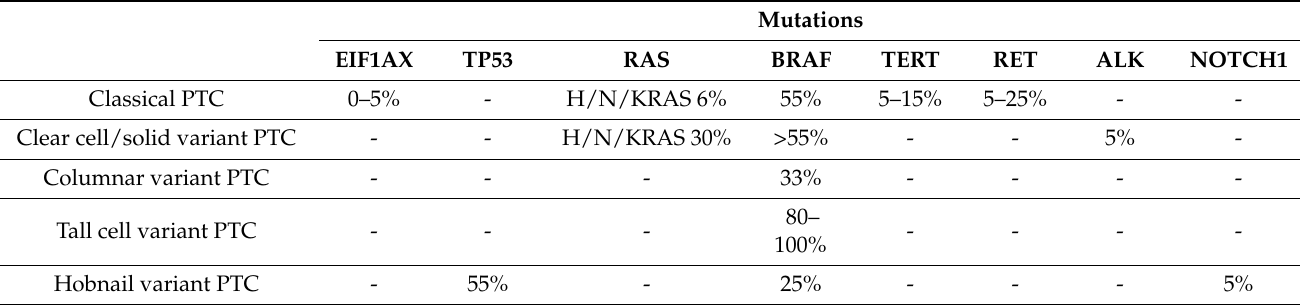
Table 3. Histological and molecular heterogeneity in PTC.